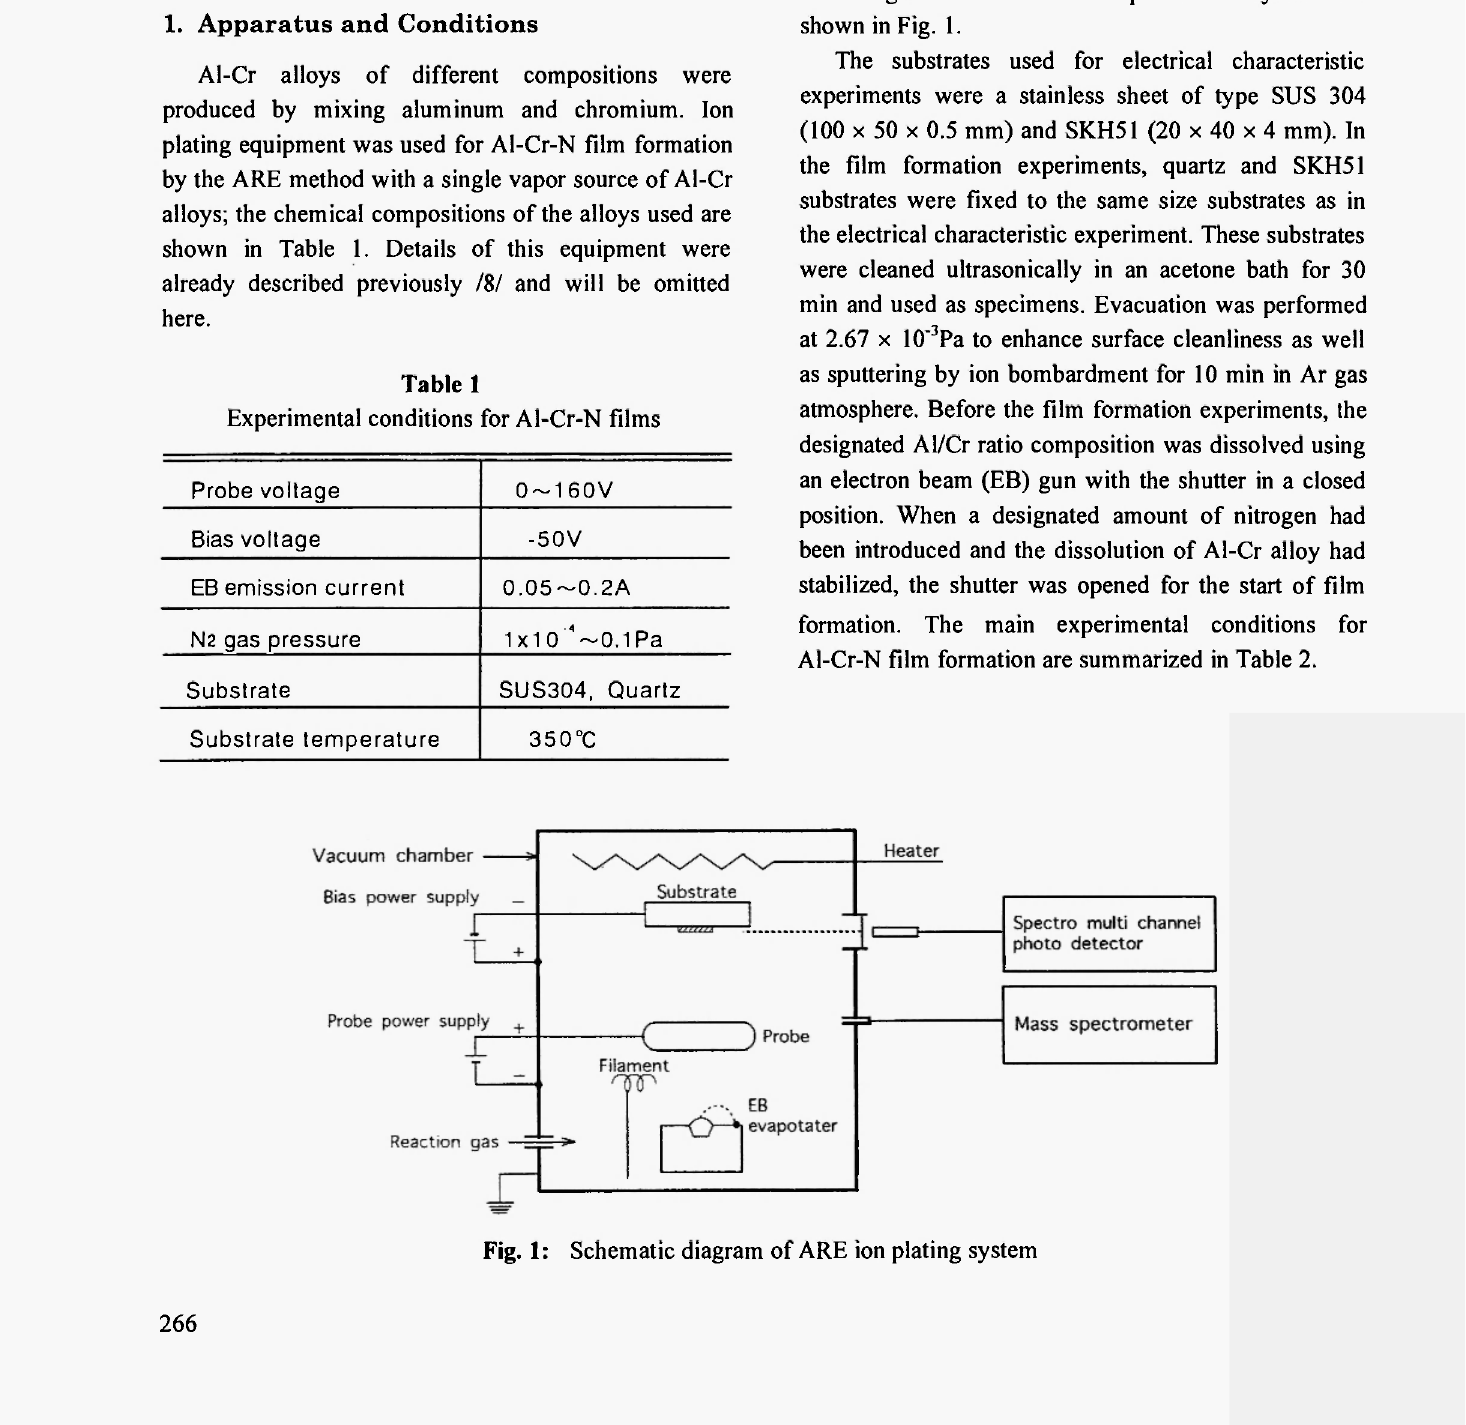
Experimental conditions for Al-Cr-N films